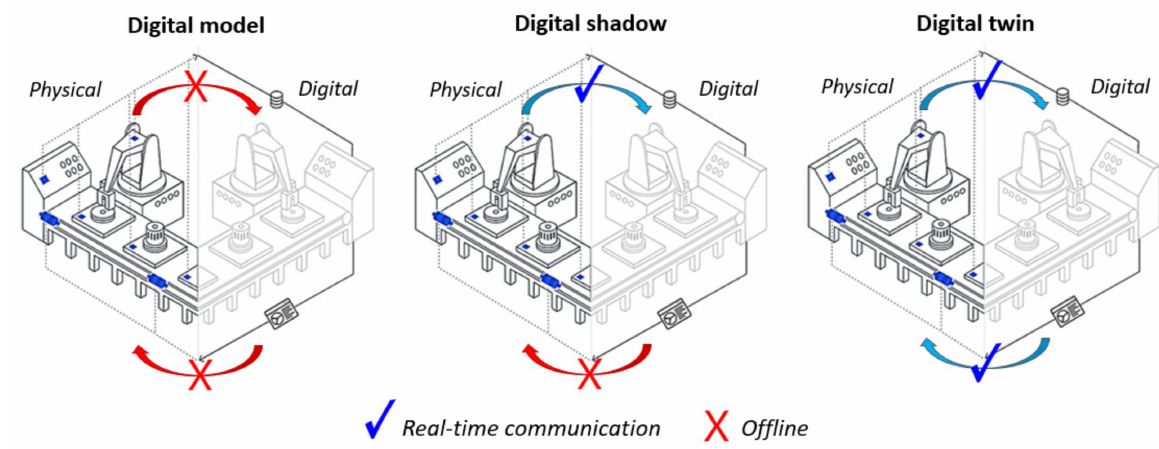
Figure 1. Levels of